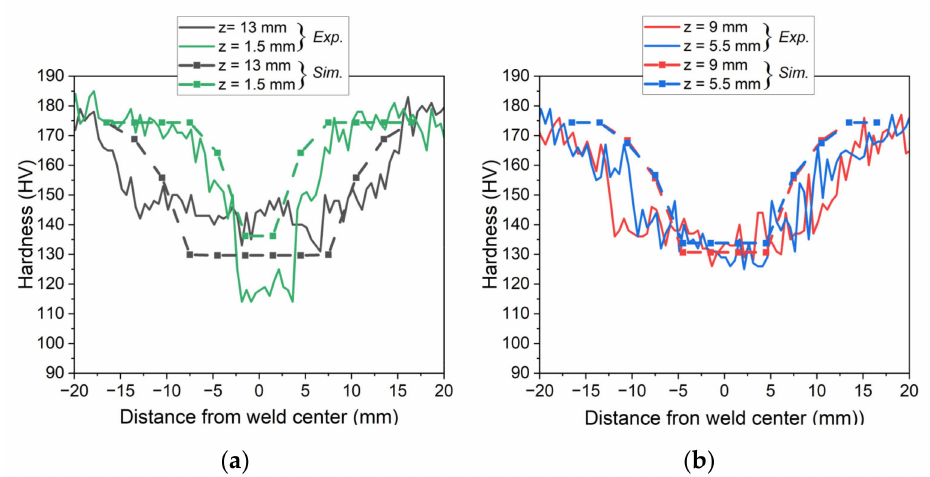
Figure 18. The experimental and simulated hardness profiles ( a ) at the top and bottom and ( b ) at the middle of the weld joint after 30 h of post-weld heat treatment at 155 ◦ C. The revised model is used for the